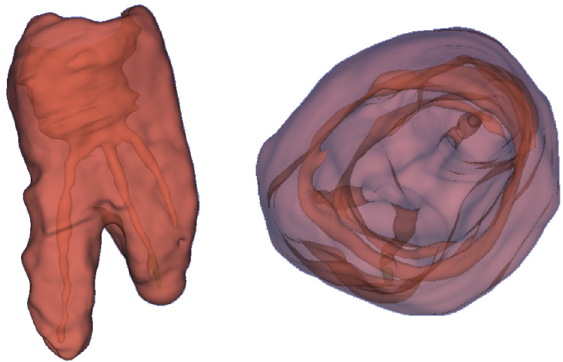
Figure 5. The 3D holograms of the tooth, with visible root canals.